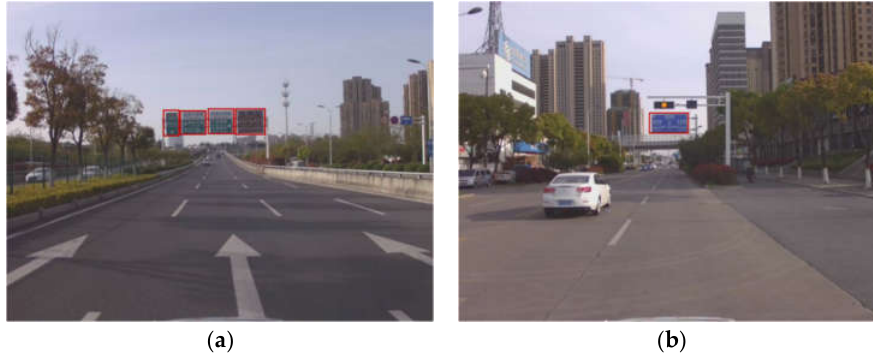
Figure 20. Traffic sign detection results: ( a ) city expressway; ( b ) ordinary urban road. Table 4. Results of the comparative experiments at daytime.